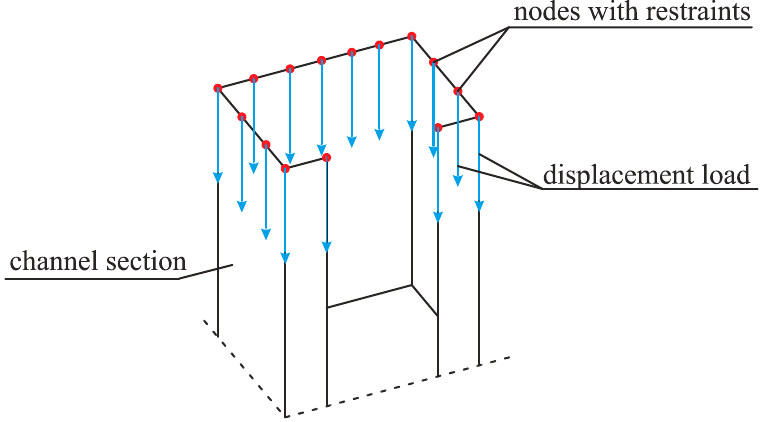
Figure 3. A pattern of displacement load subjected to the upper edges of silo columns.